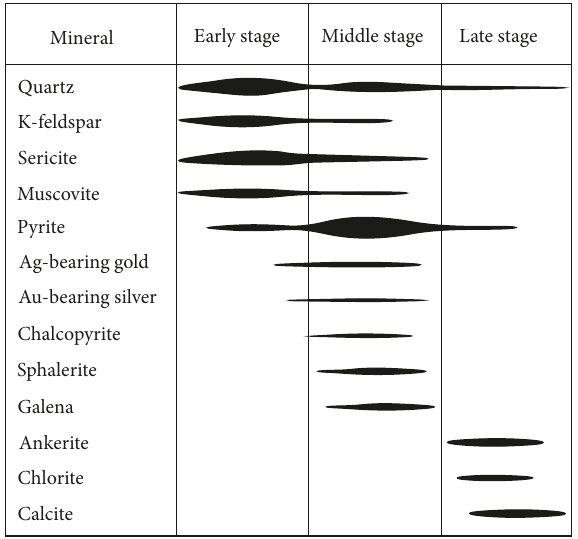
Figure 5: Paragenetic assemblages of gangue and ore minerals in the Liyuan gold deposit. Line thickness represents relative amount of the